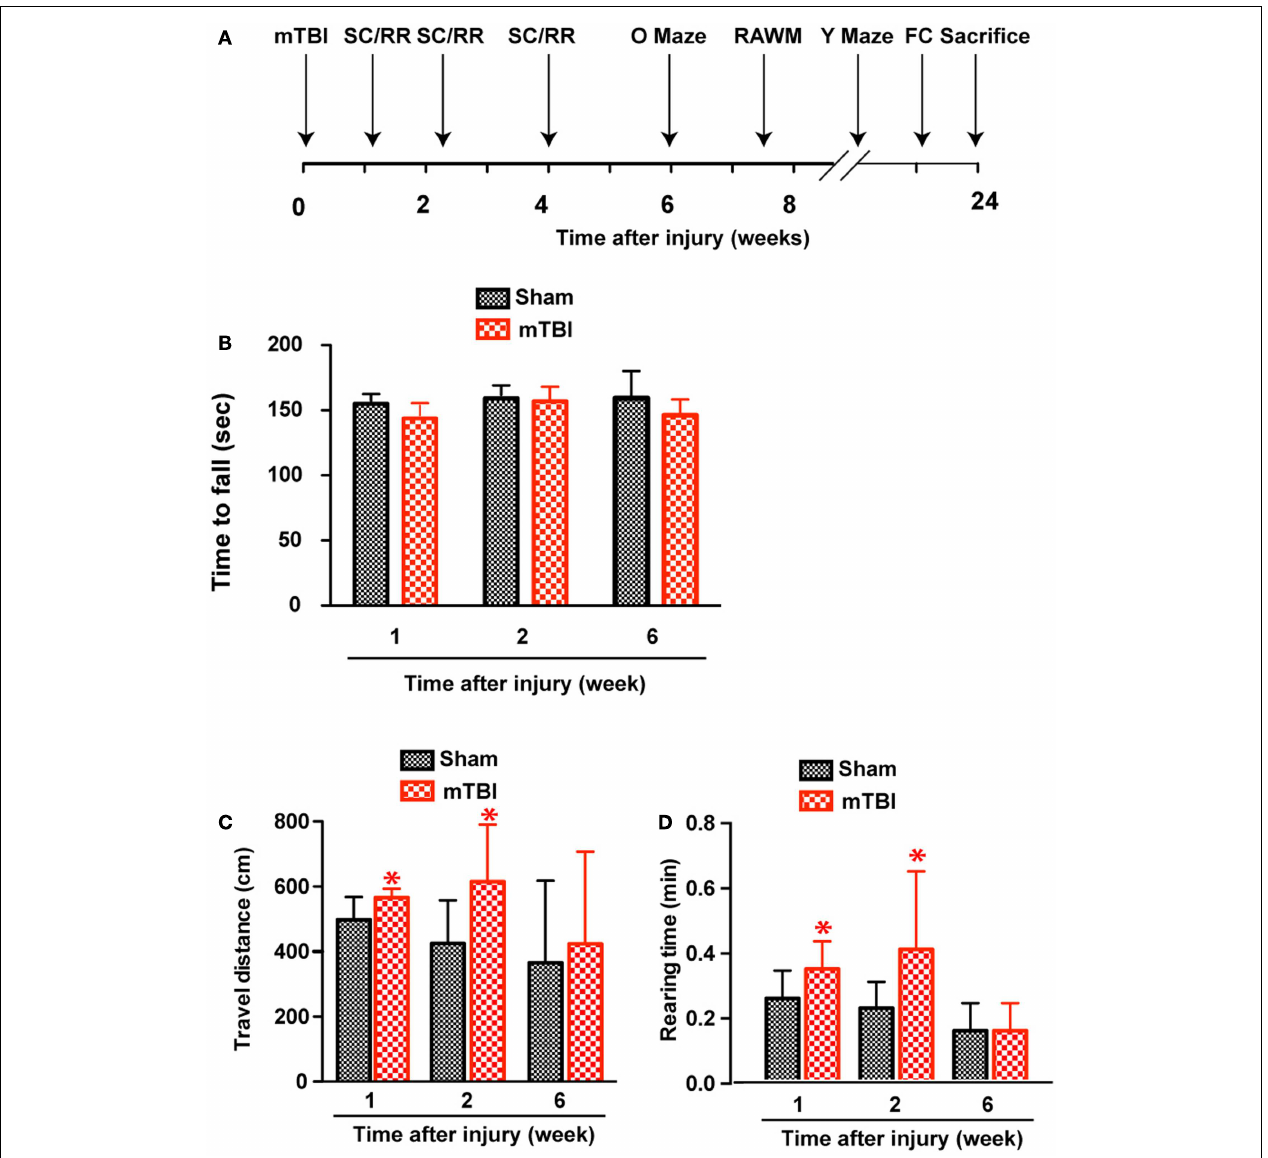
FIGURE 3 | Increased exploratory behavior after repetitive mTBI without significant motor defects .Wild-type C57BL/6J mice (male, 3months of age, body weight 24.14 ± 3.18g) received three mild impacts (mTBI) or underwent sham procedures (sham). (A) Schematic showing schedule of behavioral